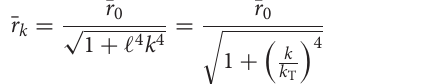
(11) The generic semiclassical RG trajectory. To go on